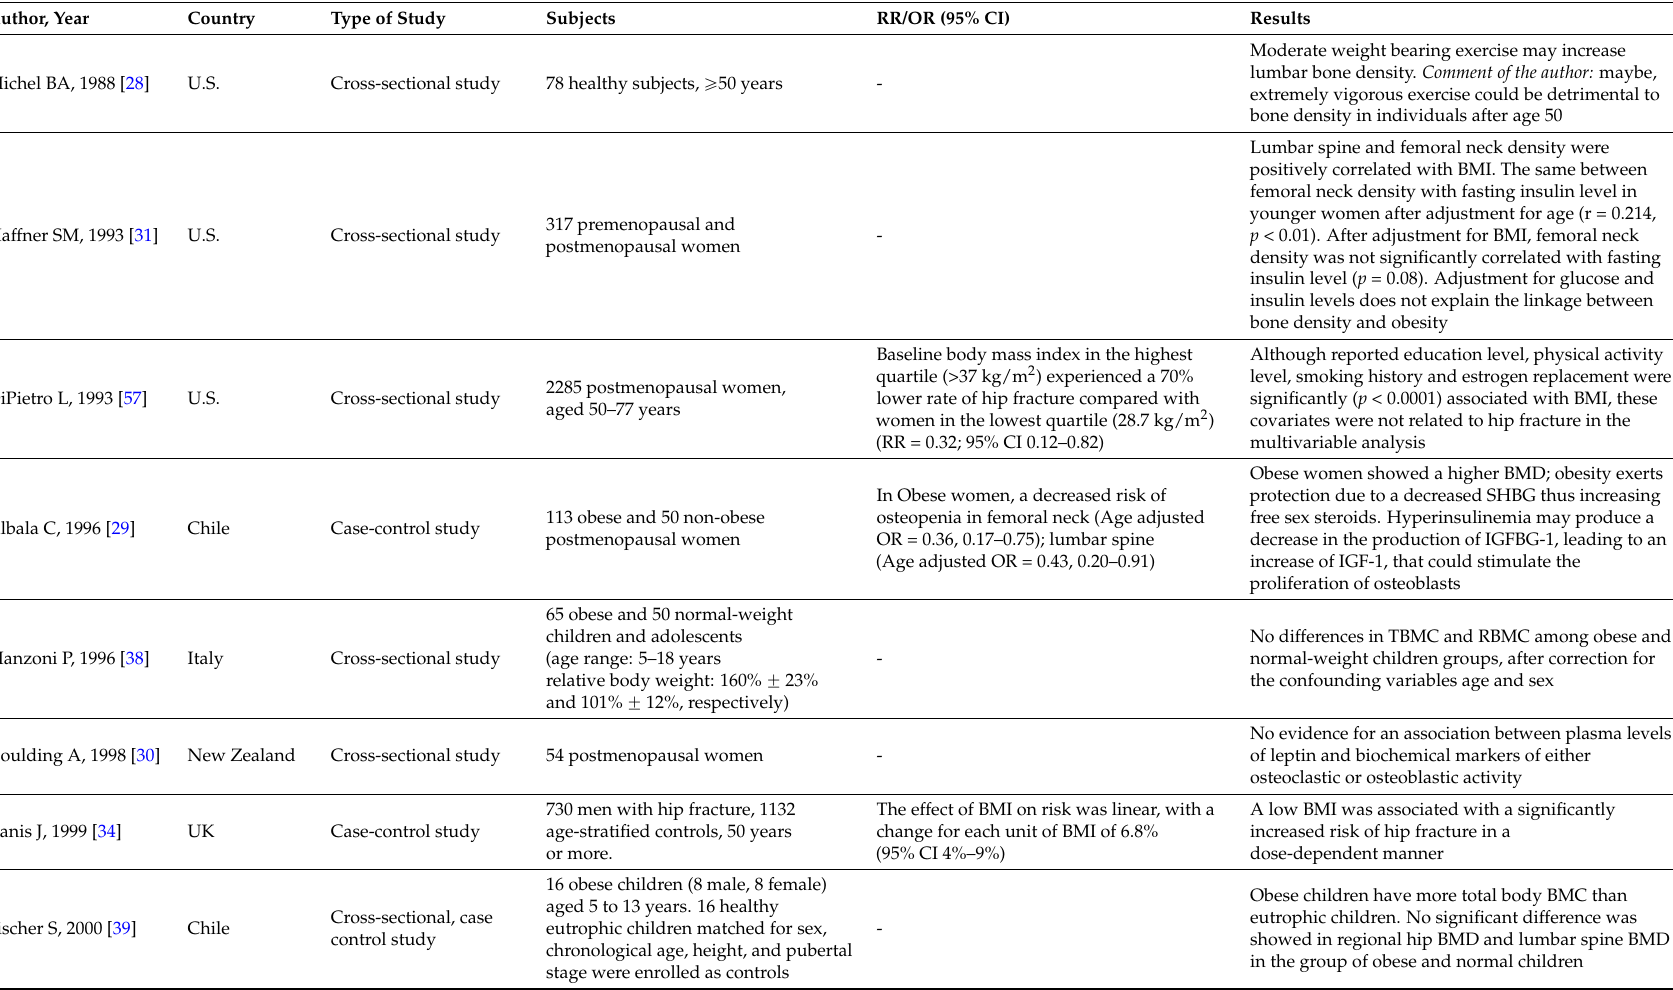
Table 1. Cross-sectional studies and case-control designs focused on the relation between Obesity and bone health in